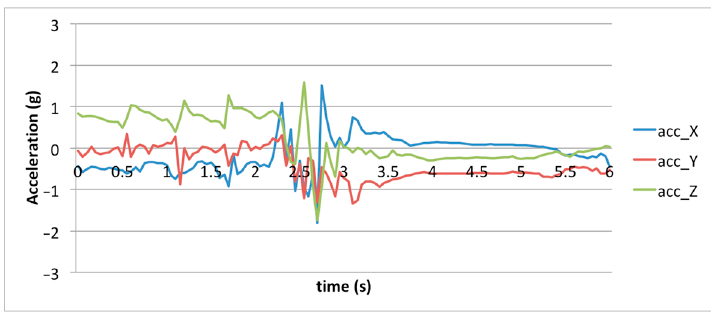
Figure 5. Accelerometer data on X, Y, Z, axes during a fall event.